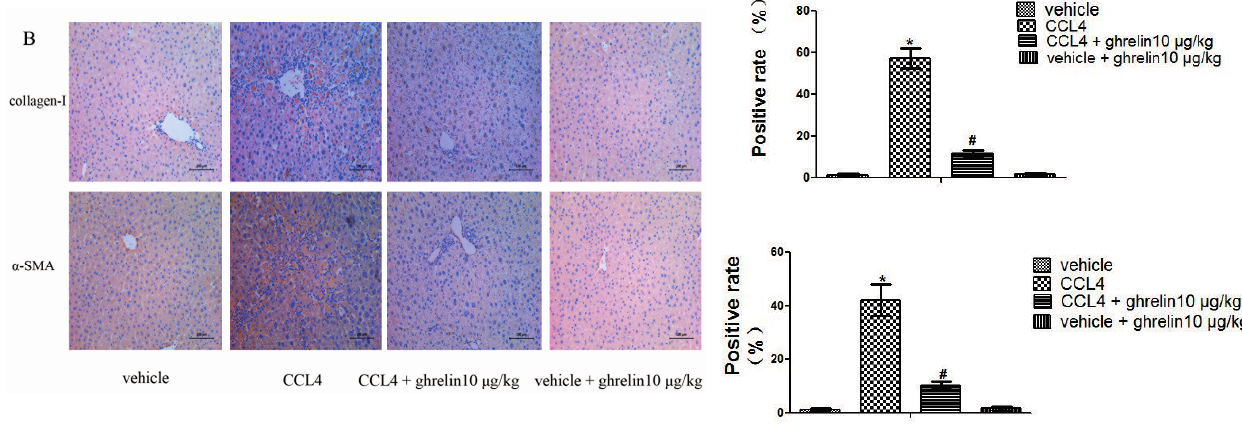
Figure 2. Ghrelin inhibited activation of HSCs and expression of MMP2 and TIMP1 in CCl 4 -induced liver fibrosis. ( A ) Results of Western blot and real-time PCR analyses of collagen I, α -SMA, TIMP1, and MMP2 in the CCl 4 group; and ( B ) Immunohistochemical staining (200×) showed increased expression of collagen I and α -SMA proteins in CCl 4 -induced fibrotic liver tissues. The positive rate was analyzed with Image-Pro Plus 6.0. Data are expressed as the mean ± SD ( n = 7, * p < 0.05 for CCl 4 vs. vehicle group, # p < 0.05 for ghrelin + CCl 4 vs. CCl 4 group). HSCs: hepatic stellate cells; MMP: matrix metalloproteinase; TIMP: tissue inhibitor of matrix metalloproteinase; α -SMA: α -smooth muscle actin. The scale bar of each figure is 200 μ m, and the magnification is 200×.